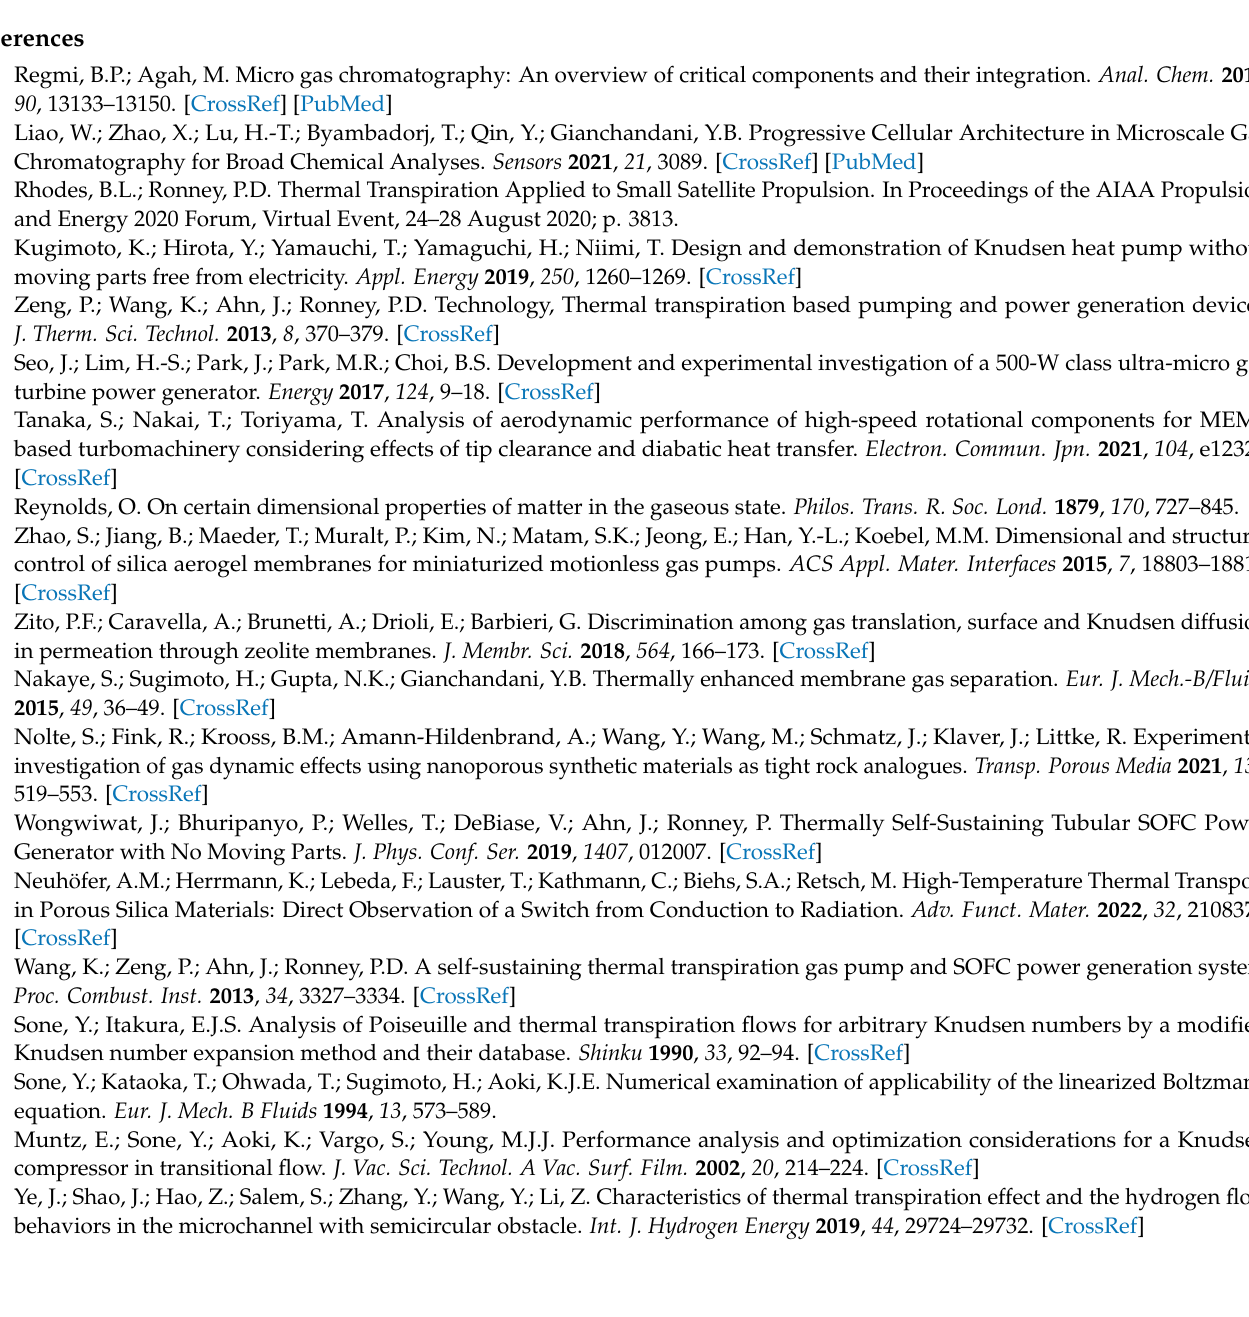
Figure A1. Graphical display of Diamond at: ( a ) 412,650 elements; ( b ) 789,356